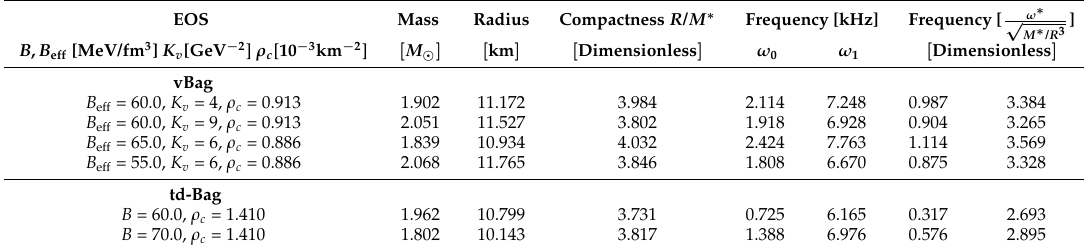
td-Bag B = 60.0, ρ c =